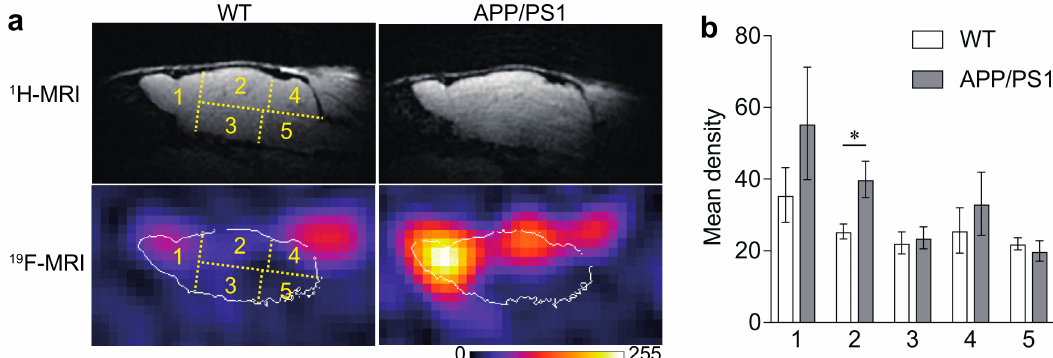
Figure 4. Accumulation of 19 F signals in the brain of APP/PS1 mice. ( a ) Representative 19 F-MR images in wild-type (WT) and APP/PS1 mice that were obtained for 50 min in the first 19 F-CSI measurement (at 100 min after the injection). A lookup table (LUT) was used to display the 19 F-MRI signal, and the white lines in each 19 F-MR image indicate the outline of the brain delineated based on the corresponding 1 H-MR images. ( b ) The levels of 19 F signals were measured in five regions indicated in yellow color. Significantly high levels of 19 F signals were detected in region 2 in APP/PS1 mice ( n = 3) compared with WT mice ( n = 4). Data are presented as mean ± SEM. * p < 0.05 (unpaired t